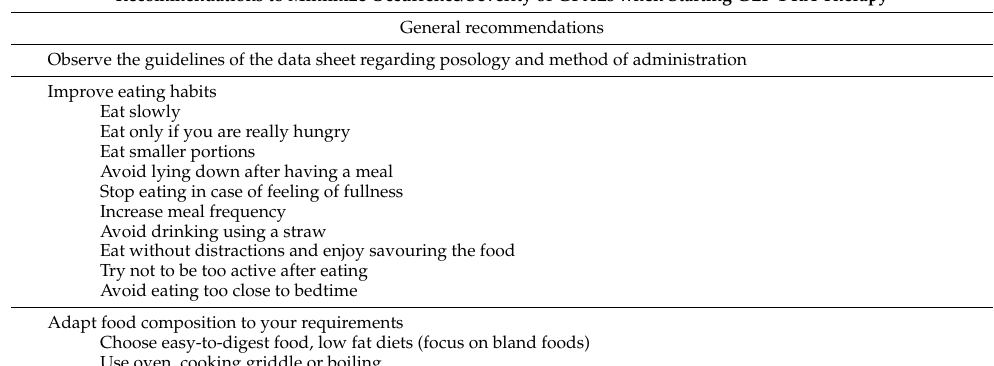
Table 2. Guidelines for